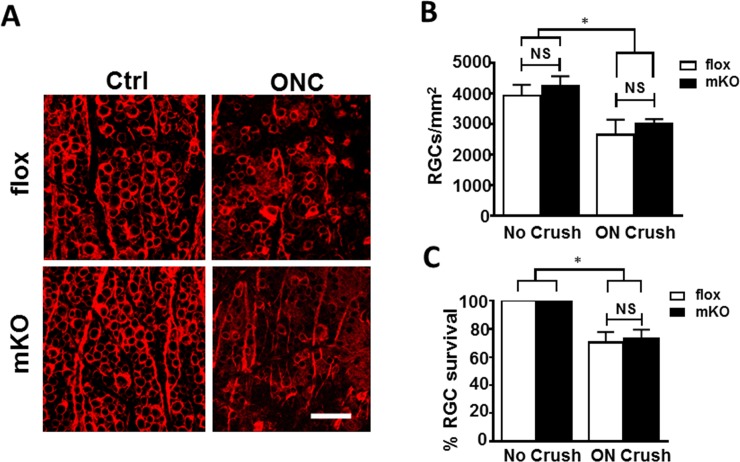
Comparable optic nerve crush injury-induced axon loss in control and mKO mice.(A) Representative images of retinal flat-mounts taken from littermate floxed control and mKO mice with (ON crush) or without (Ctrl) optic nerve crush injury that were immunolabeled for β-III-tubulin to reveal RGC morphology. Scale bar: 50 μm. (B,C) Quantifications of RGC loss density (B) and survival rate (C) following optic nerve crush injury in WT (white bar; n = 4) and mKO (black bar; n = 7) mice. (*P < 0.05; NS P > 0.05 one-way ANOVA).